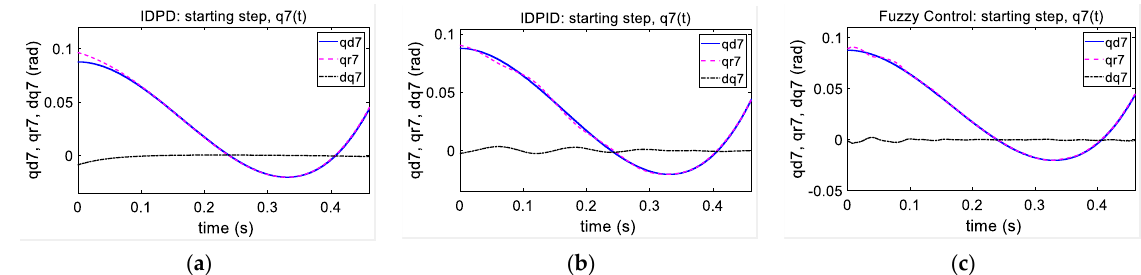
Figure 15. Simulation results of controllers for bipedal robots at the starting step: ( a ) IDPD controller; ( b ) IDPID controller; ( c ) fuzzy controller.